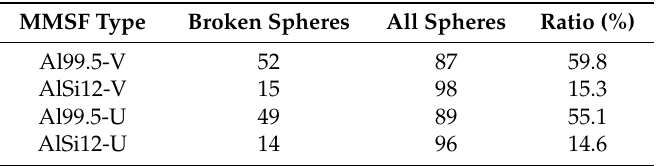
Table 3. Ratio of the broken hollow spheres on the fracture